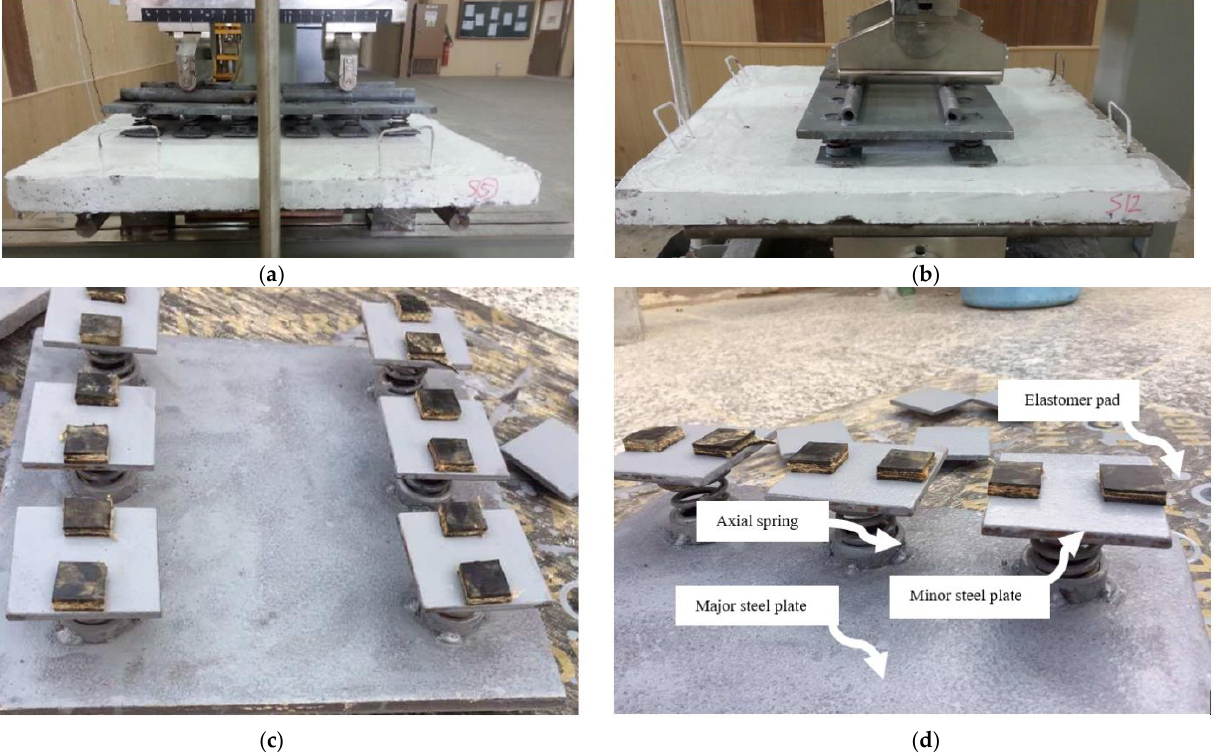
Figure 6. Load system ( a ) and ( b ) Two steel shaft on a major steel plate, ( c ) Lower face of large major steel plate, and ( d ) One line of major steel plate.